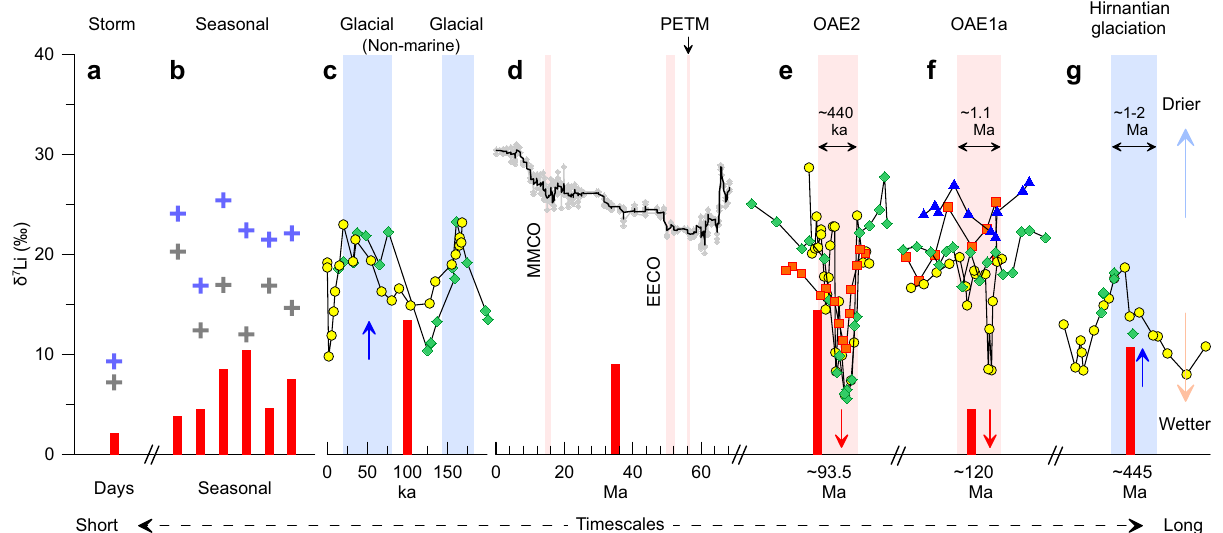
Fig. 4 Temporal evolution of δ 7 Li on various timescales ranging from days to months, millennial, and million years. ( a ) Storm events in tropical Guadeloupe showing a decrease of stream δ 7 Li from 9.3 ‰ to 7.8 ‰ within 1 – 2 days 92 , similar to the onset of monsoon at Tibetan rivers (Fig. 1). ( b ) Seasonal (time-series) variations of rivers from the Arctic to the equator, showing systematically elevated δ 7 Li in dry seasons. ( c ) Speleothems δ 7 Li from two Israeli caves during the last glacial cycle 53 . ( d ) Seawater δ 7 Li evolution during the Cenozoic 6 . Pink bars mark global climate events, including Paleocene-Eocene Thermal Maximum (PETM, ~56 Ma), Early Eocene Climatic Optimum (EECO, 50 – 52 Ma) and Mid Miocene Climatic Optimum (MMCO, 14 – 17 Ma). ( e ) and ( f ) Marine carbonate δ 7 Li of two major Ocean Anoxic Events (OAE1a, ~120 Ma) 63 and (OAE2, ~93.5Ma) 5 . ( g ) Marine carbonate δ 7 Li during the end-Ordovician Hirnantian glaciation (~445Ma) 68 . The events of OAE2, OAE1a and Hirnantian glaciation lasted for ~440ka 5 , ~1.1Ma 63 and ~1 – 2Ma 68 , respectively. Blue bars for dry events in c and g exhibit positive δ 7 Li excursions. Pink bars for wet events in d , e and f show lower δ 7 Li values (EECO and PETM), and negative δ 7 Li excursions (MMCO, OAE2 and 1 a ). The red bars in c – g show the excursion amplitudes of δ 7 Li (de fi ned as δ 7 Li dry - δ 7 Li wet ) during the events, with blue and red short arrows showing positive and negative excursion, respectively. See Fig. 2 for the legends in a and b . Different symbols in e and f represent marine carbonate sections at different locations, and in g represents bulk carbonates and brachiopods at same location. Errors for δ 7 Li are similar to the symbol